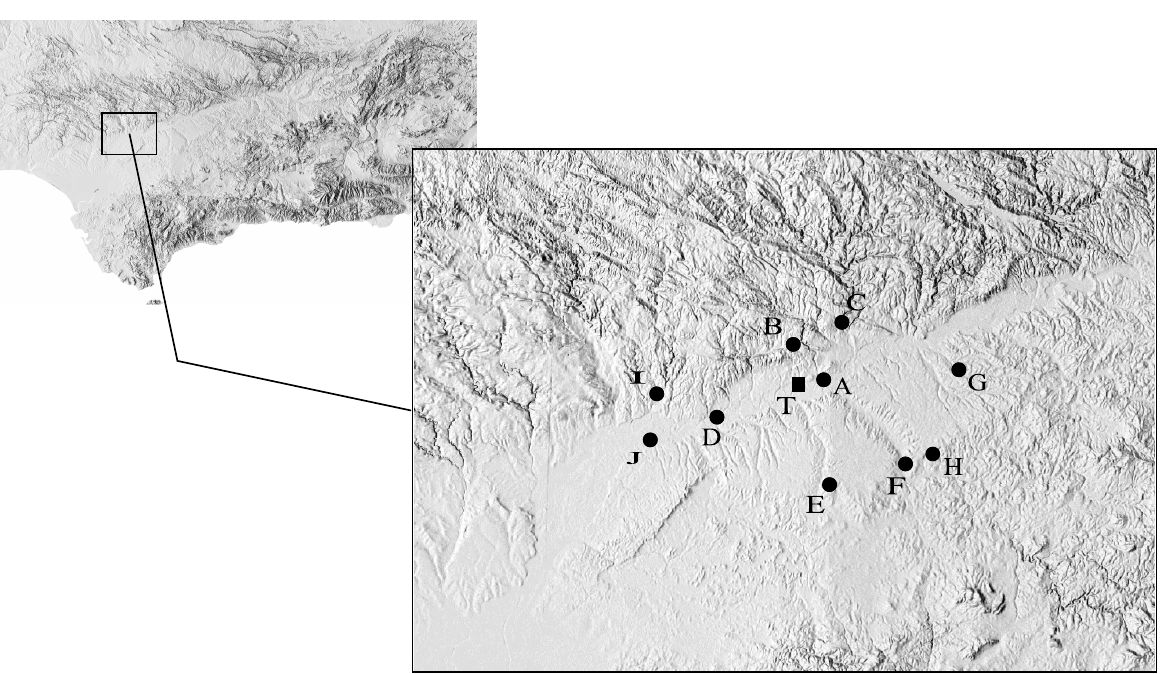
Figure 2. Map of the studied zone. T = target station.